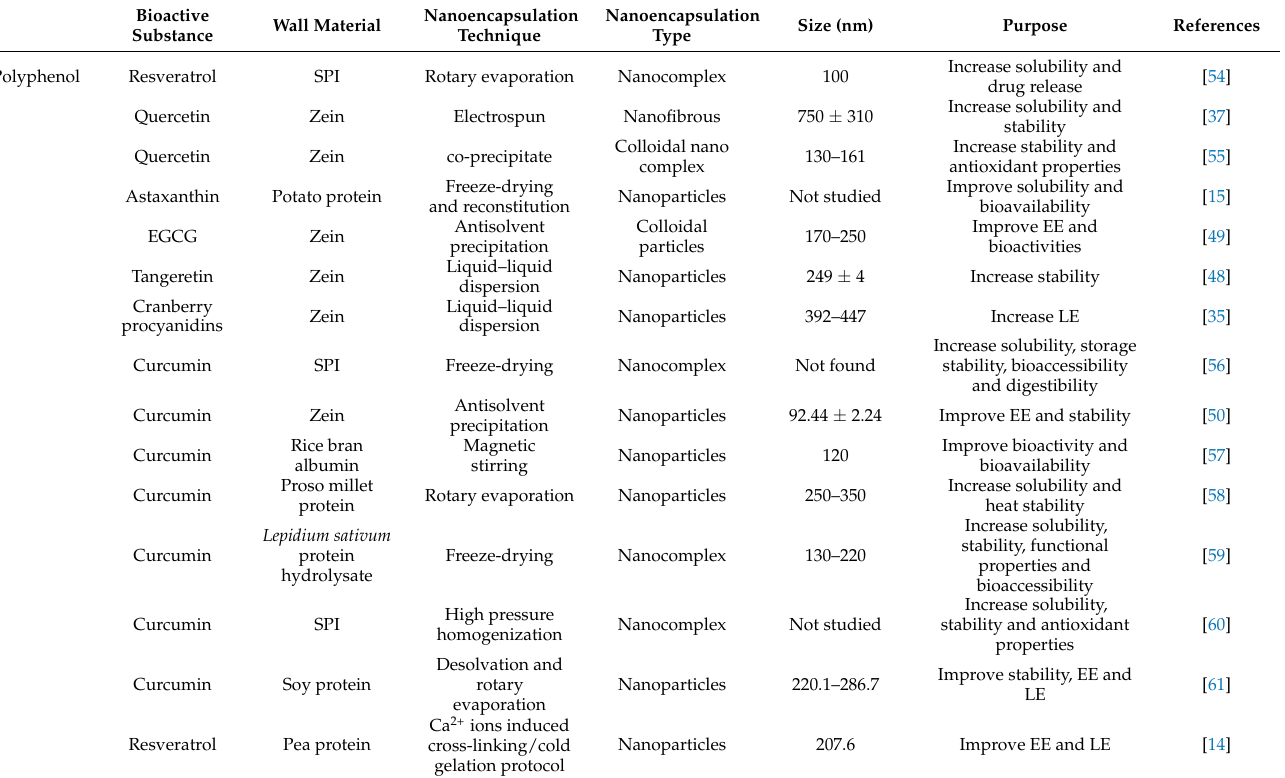
Table 2. Summary of plant protein-based nanocarriers used to deliver active